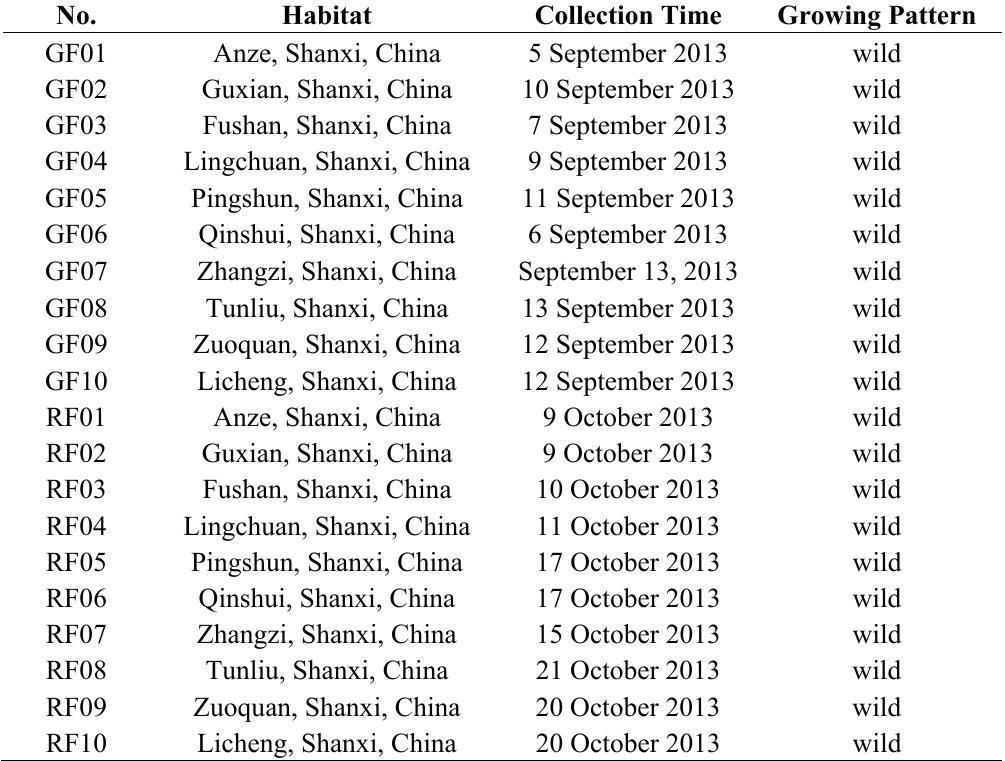
Table 3. Representative samples of GF and RF in this